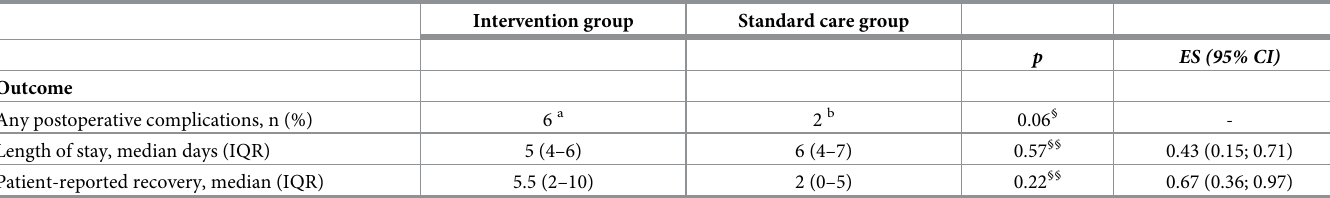
Table 6. Postoperative outcomes of intervention group (n = 10) versus standard care group (n =